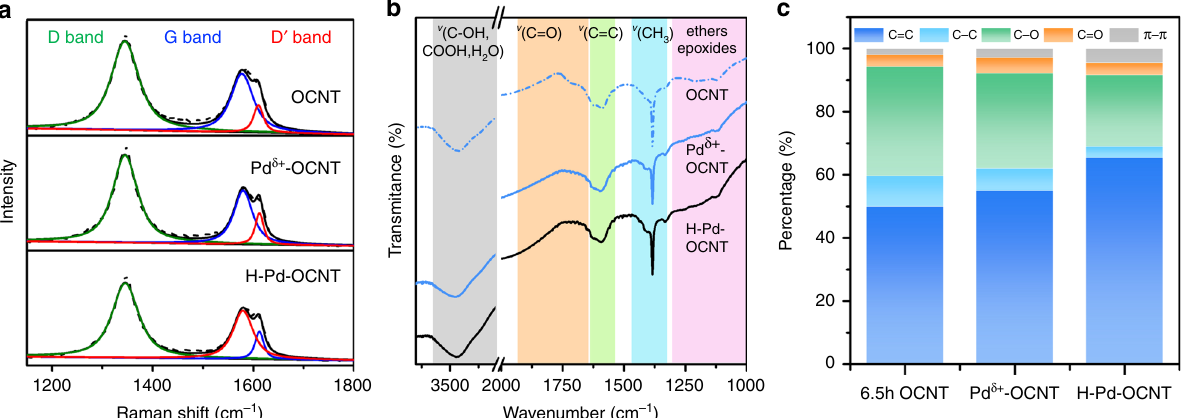
Fig. 2 Characterization of defects and functional groups in Pd δ + -OCNT and H-Pd-OCNT electrocatalysts. Raman spectra a and FTIR spectra b of 6.5 h OCNT, Pd δ + -OCNT and H-Pd-OCNT. Peak assignments are listed in the Supplementary Figure 7c The distribution of carbon element in different coordination environments for 6.5 h OCNT, Pd δ + -OCNT and H-Pd-OCNT measured by C1s XPS.